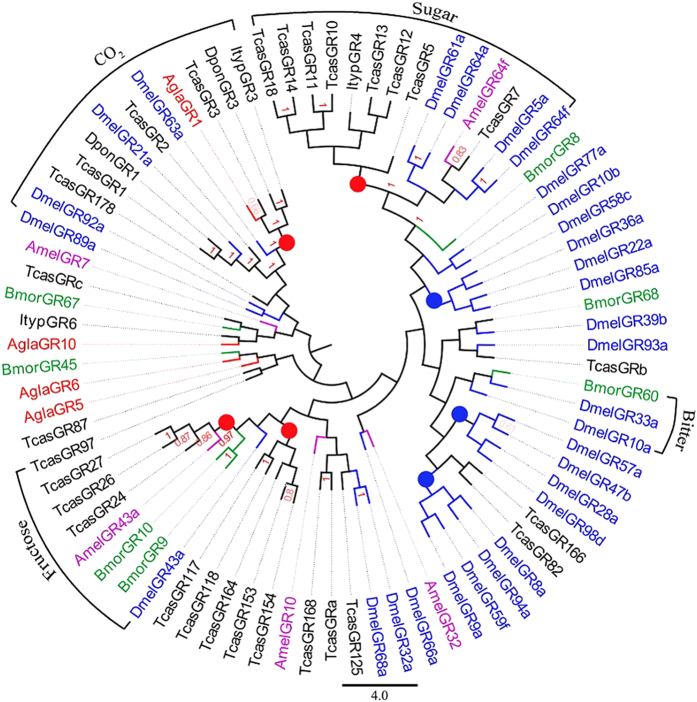
Neighbor-joining phylogenetic tree of candidate gustatory receptors (GRs).The NJ phylogenetic analysis of GRs of A. glabripennis (AglaGR, red) was performed with reference GRs of D. ponderosae (DponGR, dark), I. typographus (ItypGR, dark), T. castaneum (TcasGR, dark), Drosophila melanogaster (DmelGR, Diptera, blue), Bombyx mori (BmorGR, Lepidoptera, green), and Apis mellifera (AmelGR, Hymenoptera, purple). The stability of the nodes was assessed by bootstrap analysis with 1,000 replications, and only bootstrap values ≥0.6 are shown at the corresponding nodes. The scale bar represents 4.0 substitution per site.